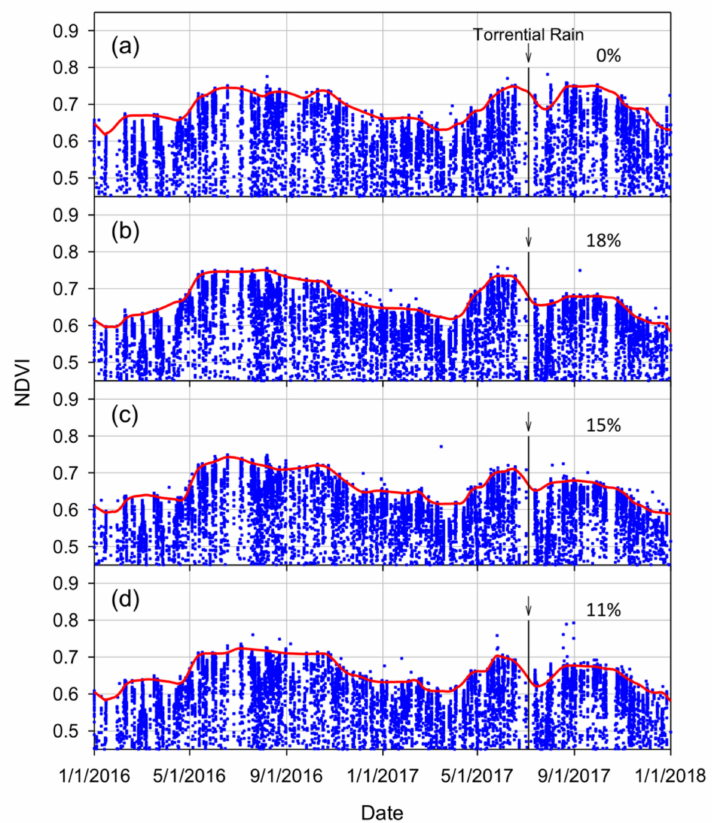
Figure 4. AHI NDVI temporal profiles of landslide-a ff ected pixels with varying degrees: ( a ) 0%, ( b ) 18%, ( c ) 15%, and ( d ) 11% landslide areas. The filled squares are AHI NDVI values, whereas the red lines are the smoothed NDVI profiles (see Appendix A). The extraction locations of these profiles are shown in Figure